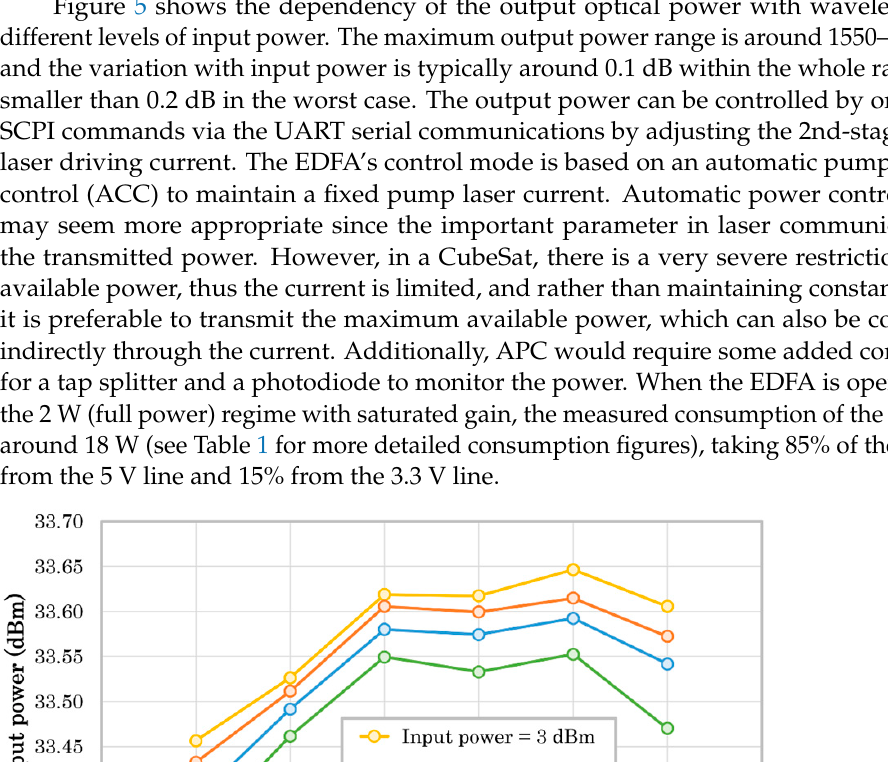
Figure 4. Spectrum-analyzer measurement of the 2-W EDFA.